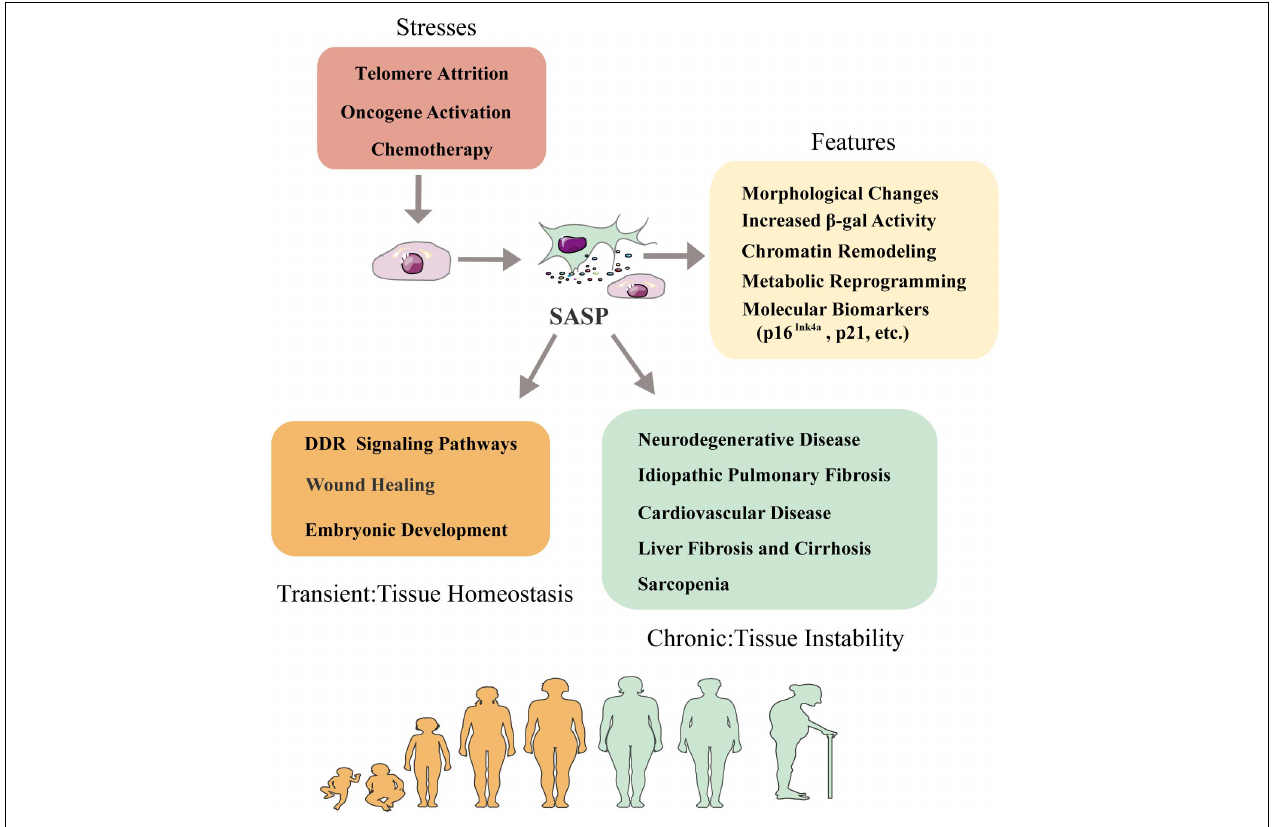
FIGURE 1 | Senescence-associated secretory phenotype and tissue homeostasis. Senescence is triggered by telomere attrition, oncogene activation and radiation or chemotherapy treatment. Senescent cells can be characterized by a series of features including morphological changes, increased β -galactosidase activity, chromatin remodeling, metabolic reprogramming, secretion of SASP factors and molecular biomarkers like p16 Ink4a , p21, etc. Influence of SASP in tissue homeostasis is context dependent: in short term, SASP factors involve DDR signaling pathways, wound healing and embryogenesis to help maintain tissue homeostasis; in long term, SASP factors promote immunosenescence in aging-relative diseases such as neurodegenerative diseases, idiopathic pulmonary fibrosis, cardiovascular disease, liver fibrosis and cirrhosis, sarcopenia and skin aging. DDR, DNA damage